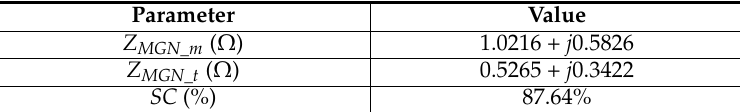
Figure 17. Results of the estimated g based on LSM (single broken point). Table 6. Estimation results of Z MGN_m and SC .